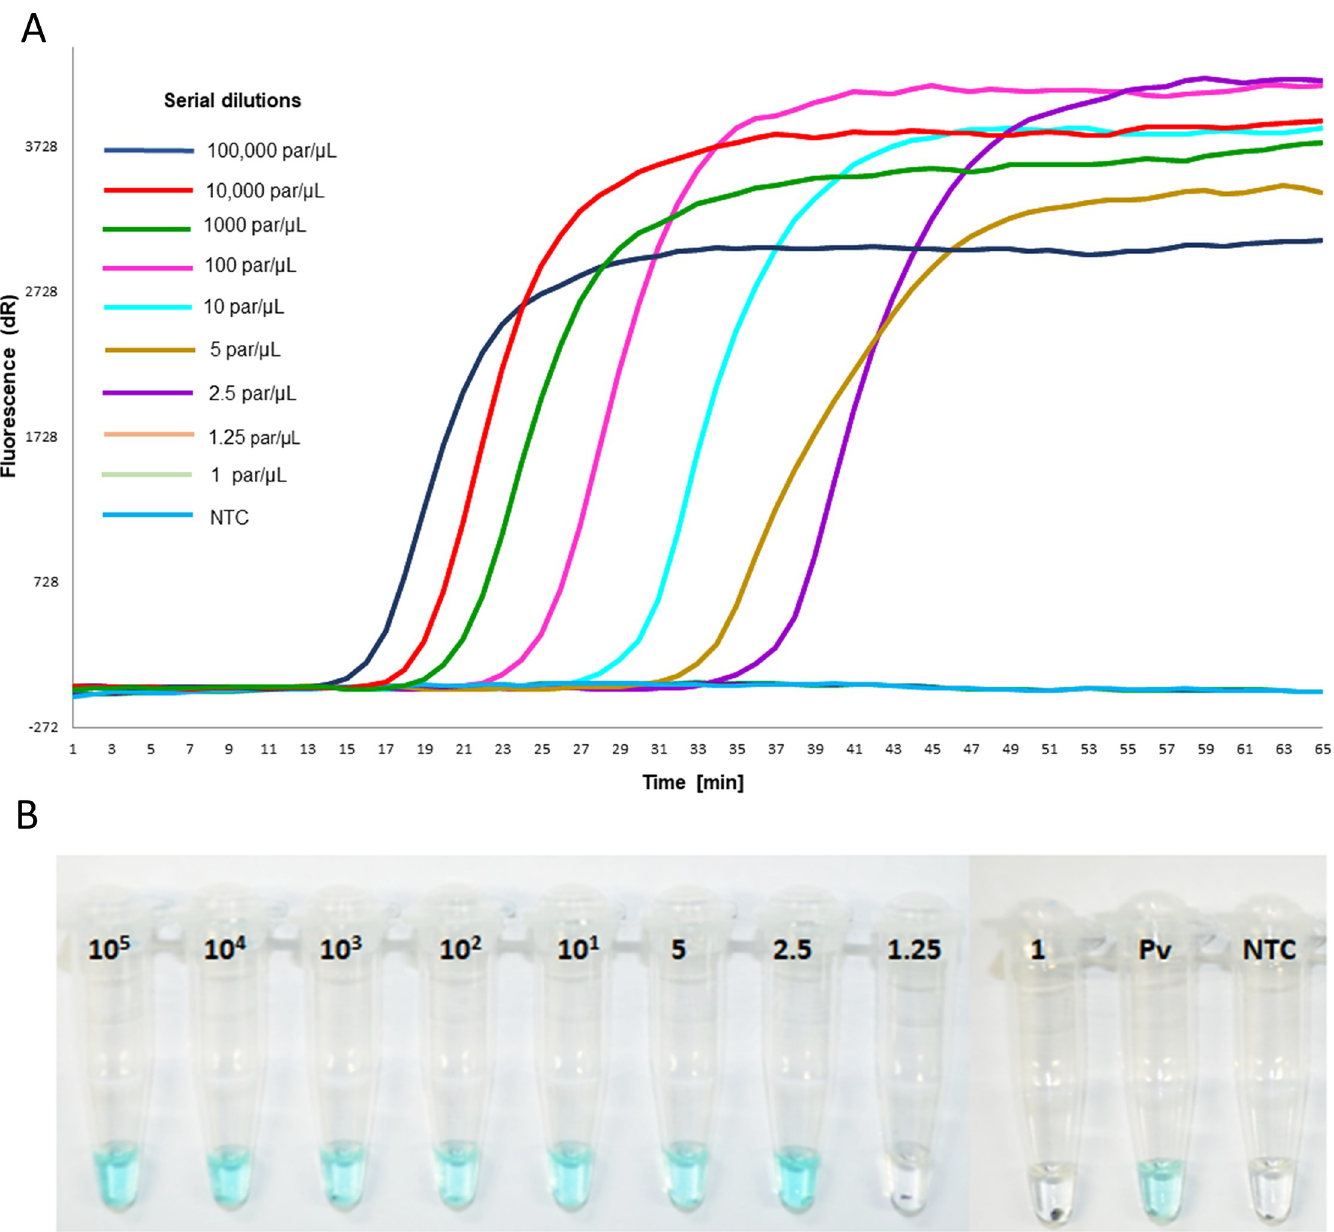
Fig 2. Limit of detection (LoD) of the genus-specific LAMP assays from 10-fold and 2-fold serial dilutions of P . falciparum reference strain 3D7. A. RealAmp amplification curves (positive) were observed from concentrations between 100,000(10 5 ) and 2.5 parasites/ μ l dilution. B. Colorimetric MG-LAMP results can be visualized with the naked-eye, blue/green indicate positive whereas colorless negative. Pv: P . vivax control and NTC: no template control. Range 10 5 –1 = #parasites/ μ l. https://doi.org/10.1371/journal.pone.0234263.g002 and 1 mixed infection ( P . falciparum and P . vivax )) with a median asexual parasitemia of 6,092.7 parasites/uL (range: 36–69,235 parasites/ μ L) and median gametocytemia of 1,167.8 parasites/uL (range: 12–44,490 parasites/ μ L). Nested-PCR identified a higher number of mixed infections resulting in 33 P . falciparum , 58 P . vivax and 11 mixed infections, Table 1. Using nested-PCR as reference, microscopy had a sensitivity of 88.2% (95% CI: 80–93.5%) and specificity of 100% (95%: 87.4–100%). The genus-RealAmp method had 99.0% sensitivity